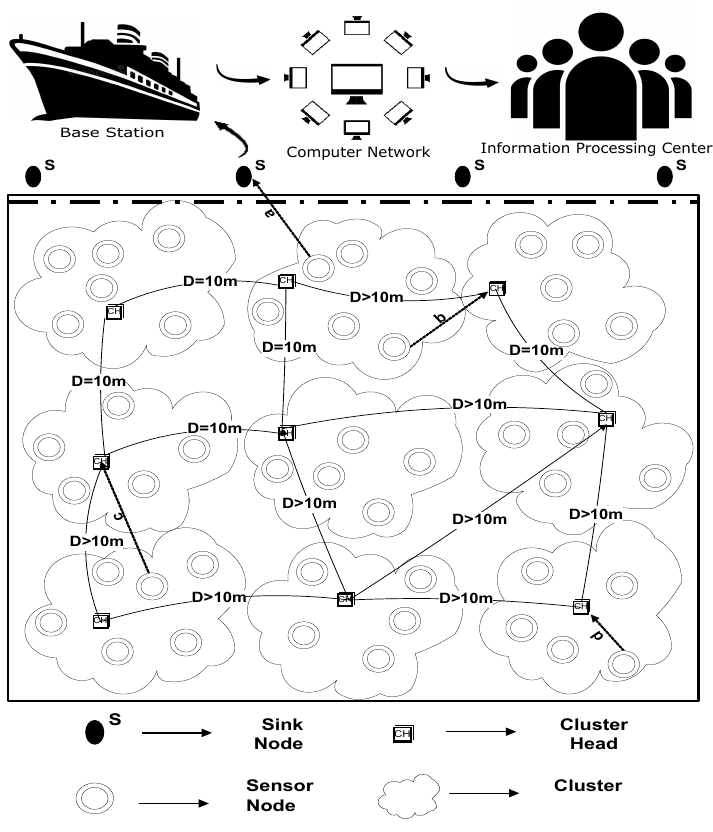
Figure 1. General Architecture of U-(ACH) 2